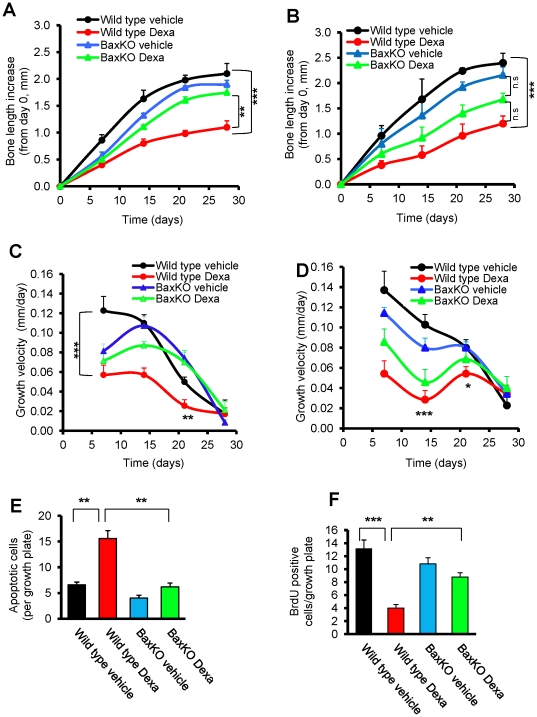
Bax deficiency protects mice from Dexa-induced bone growth impairment.Bax knockout (BaxKO) and wild-type female and male mice were treated with Dexa (2 mg/kg body weight/day) or saline for 28 days. X-ray images were captured on days 0, 7, 14, 21, and 28, and left femur lengths were measured. Femur bone length increase from day 0 in (A) female mice (***p<0.001, wild type Dexa vs. wild type vehicle; **p<0.01, wild type Dexa vs. BaxKO Dexa; n = 5) and (B) male mice (***p<0.001, wild type Dexa vs. wild type vehicle., n.s = not significant; n = 5.). Femur growth velocity (mm/day) in (C) female mice (***p<0.001, wild type Dexa vs. wild type vehicle.,**wild type Dexa vs. BaxKO Dexa., n = 5) and (D) male mice (***p<0.001, *p<0.05, wild type Dexa vs. wild type vehicle; n = 5). (E) TUNEL assays for the detection of apoptotic chondrocytes in growth plates of BaxKO and wild-type female mice treated with Dexa or vehicle for 28 days (**p<0.01, wild type Dexa vs. wild type vehicle., **p<0.01, wild type Dexa vs. BaxKO Dexa, n = 5). (F) BrdU incorporation analysis for the assessment of chondrocyte proliferation in growth plate cartilage of BaxKO and wild-type female mice treated with Dexa or saline for 28 days. (***p<0.001, wild type Dexa vs. wild type vehicle; **p<0.01, wild type Dexa vs. BaxKO Dexa; n = 5).